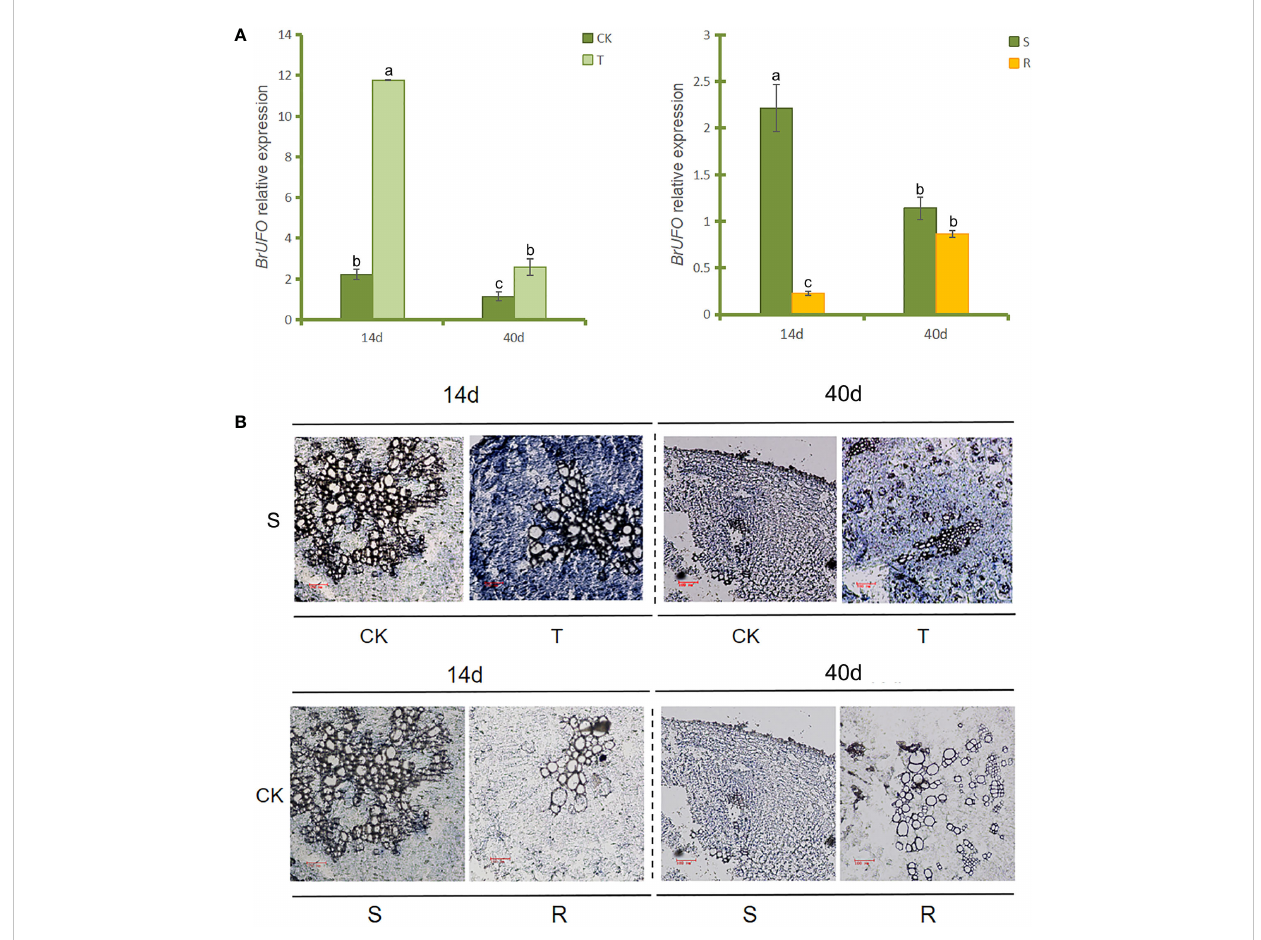
FIGURE 1 BrUFO expression patterns. (A) qRT-PCR analysis of BrUFO . Results are mean ± standard deviation (n = 3). Each set of data represents the mean of its three replicates, and the error line represents the standard deviation of its three replicates. Letters indicate signi fi cant differences at p ≤ 0.05 according to Duncan ’ s multiple range test. (B) In situ hybridization analysis of BrUFO . Roots samples were collected on the 14 th day after inoculation with P. brassicae (when zoospores of P. brassicae can be observe d in the root hairs under the ordinary light microscope), and on the 40 th day after inoculation with P. brassicae (when obvious club symptoms are appear on roots); S, susceptible material of Chinese cabbage susceptible material ’ SN742 ’ ; R, Chinese cabbage resistant material ‘ SN205 ’ ; CK, control roots not inoculated with Plasmodiophora brassicae ; T, treated roots inoculated with Plasmodiophora brassicae